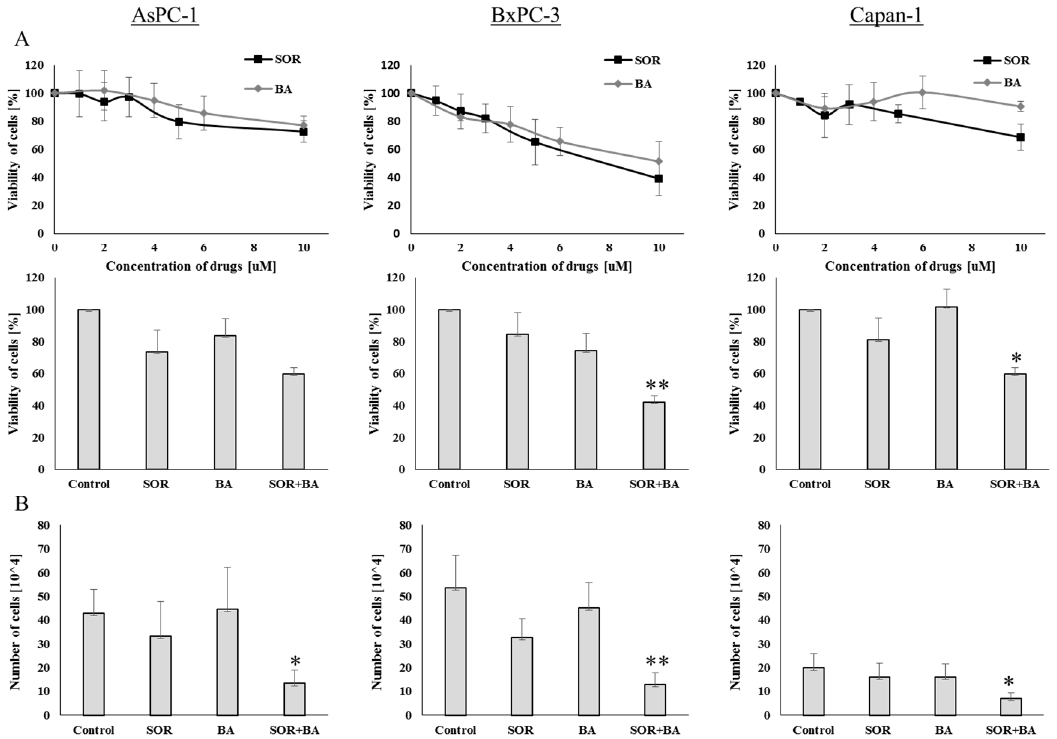
Figure 1. Effect of combination treatment with sorafenib (SOR) and betulinic acid (BA) on cell growth inhibition of PDAC cell lines. ( A ) Viability of AsPC-1, BxPC-3, and Capan-1 cells after exposure to sorafenib and betulinic acid at different drug concentrations alone and in combination. ( B ) The number of AsPC-1, BxPC-3, and Capan-1 cells after treatments with sorafenib (AsPC-1 and Capan-1: 5 µ M, BxPC-3: 3 µ M) and betulinic acid (6 µ M) alone and in combination ( n = 4). Data are presented as means ± SD normalized to the untreated control. * p < 0.05, ** p < 0.01 compared with the sorafenib treatment group and betulinic acid treatment group.